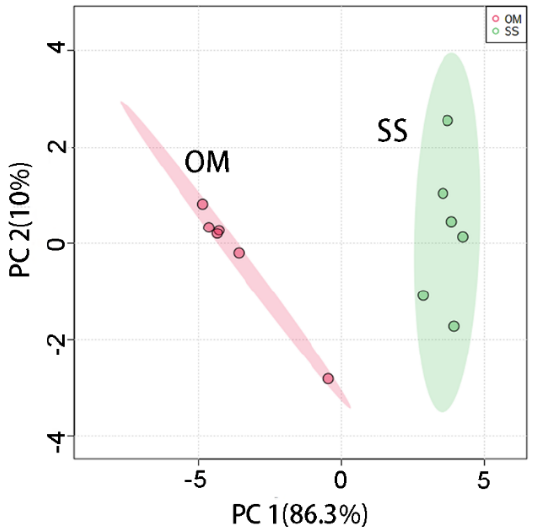
Figure 5. PCA score plot of UV-Vis spectra of Oncorhynchus mykiss (OM) and Salmo salar (SS). Six UV-Vis spectra were obtained from each fish species. During the experiment, three slices of Salmo salar samples were analyzed. Three OM fish samples were analyzed. The initially obtained extracts were diluted 80-fold with deionized (DI) water for further analysis.